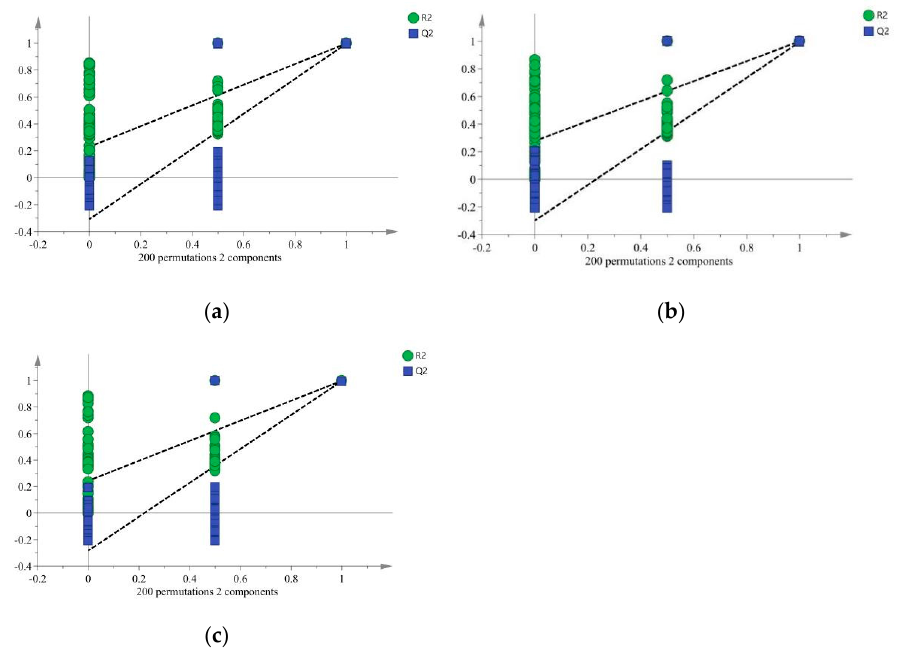
(b) Figure 3. PLS − DA model for aroma components at di ff erent stages of the three species.( a ) Score scatter plot; ( b ) Loading scatter plot. Overfitting is a well-known issue with the PLS-DA model, thus a permutation test was used to validate the model’s accuracy (Figure 4). The three species included in the